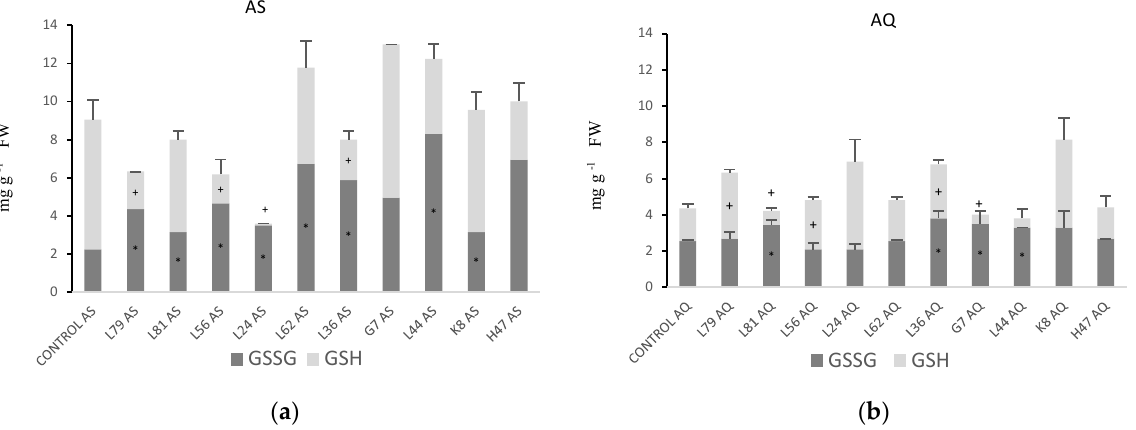
Figure 7. Glutathione concentration (mg g − 1 FW) of oxidized glutathione (GSSG) and reduced glutathione (GSH) ( a ) in AS and ( b ) AQ, in leaves of plants inoculated with the 10 PGPB and non- inoculated controls. Values are the average ± SE (n = 3). Asterisks (*) and (+) indicate significant differences with the controls according to t student ( p < 0.05) for GSSG and GSH, respectively.